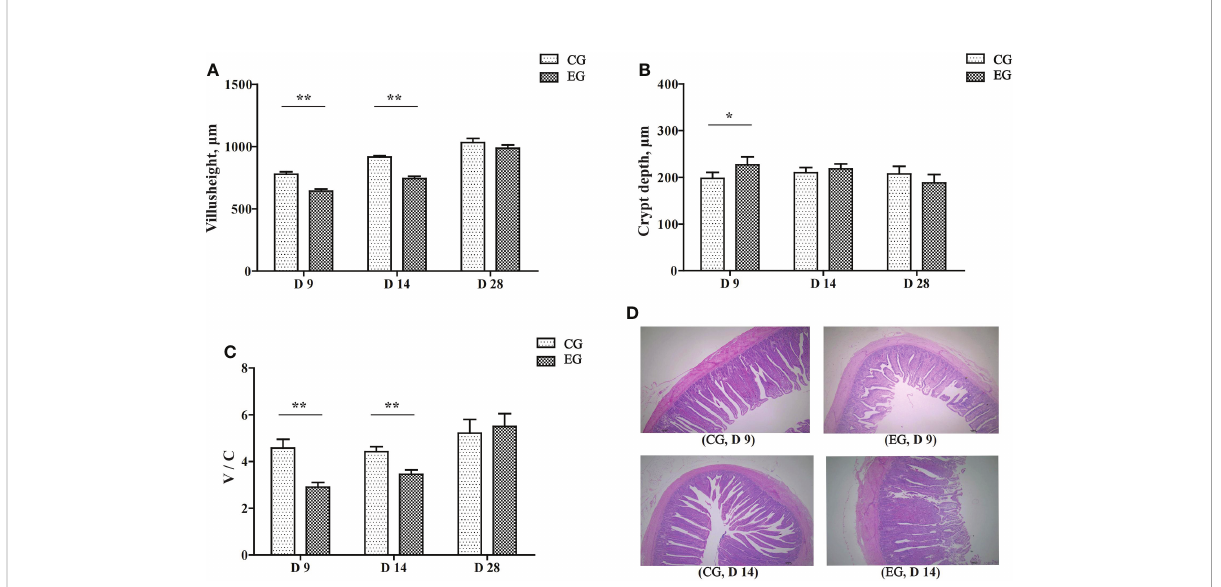
FIGURE 2 Effect of the Escherichia coli challenge on the jejunum histomorphology of the ducks. CG, control group (non-challenged with pathogenic ( E ) coli O88); EG, experiment group (challenged with pathogenic ( E ) coli O88). (A) Villus height in the jejunum of ducks; (B) crypt depth in the jejunum of ducks; (C) the ratio of villus height/crypt depth in the jejunum of ducks; (D) histological damage in the jejunum of ducks on days 9 and 14 (normal, villi shortened, damaged, and eroded). Data are indicated as means ± SEM ( n = 6), * 0.01 < P < 0.05; ** P <